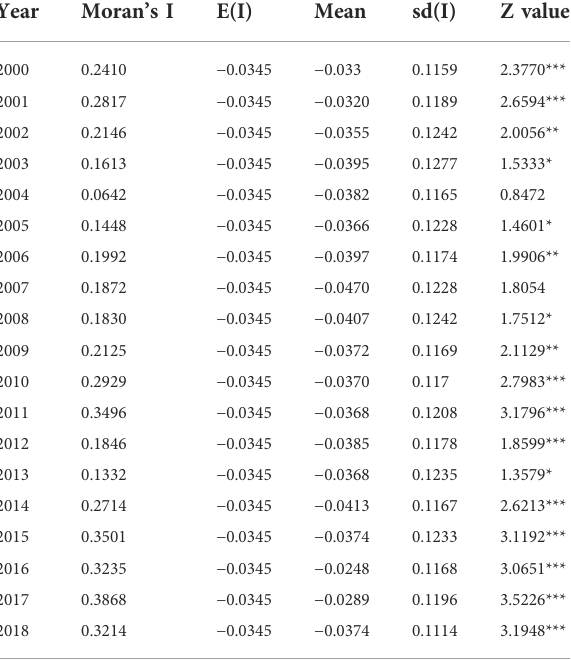
TABLE 4 Global Moran ’ s I of